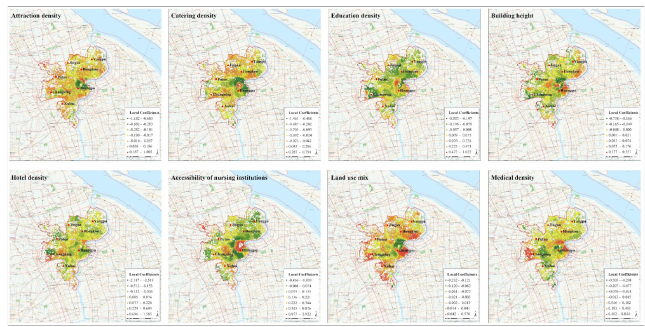
Figure 8. The spatial distribution of the GWR local